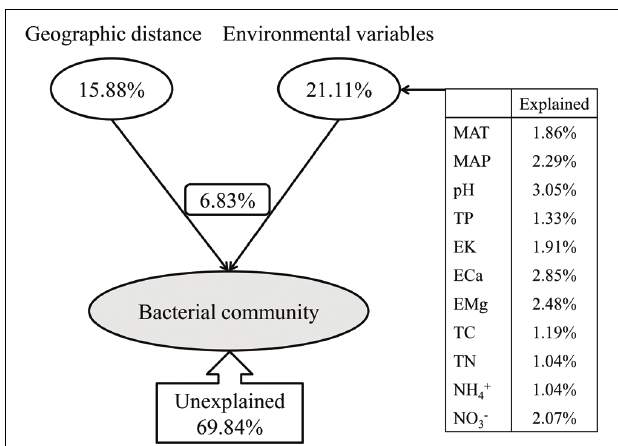
FIGURE 9 | Variation partition analysis of the effects of geographic distance and environmental variables on the bacterial community. The environmental variables show different contributions to the variation of the bacteria community. MAT and MAP represent mean annual temperature and mean annual precipitation; TP represent soil total phosphorus contents; EK, ECa and EMg represent soil exchangeable K + , Ca 2 + and Mg 2 + contents, respectively; NH + 4 and NO − 3 represent soil extractable NH + 4 and NO − 3 levels; MBC represents soil microbial biomass